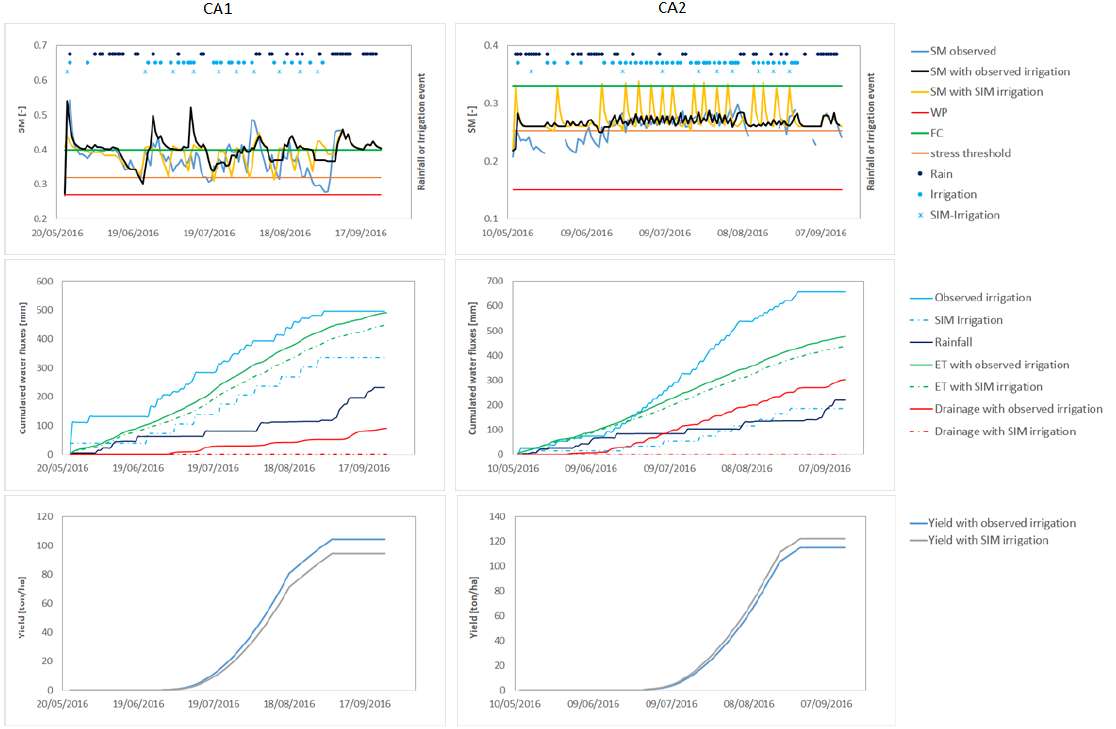
Figure 6. Comparison between water fluxes and yield for observed and SIM irrigation for Capitanata fields. Table 6. SIM strategy application in the Capitanata Irrigation Consortium.